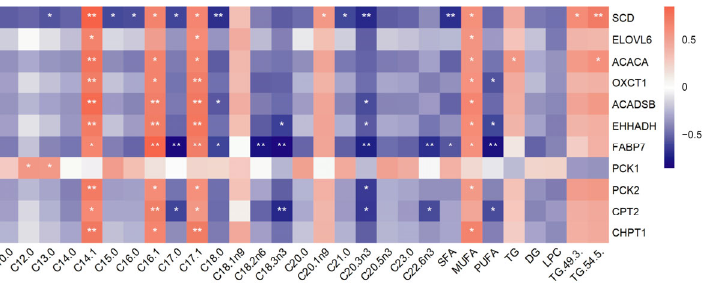
Figure 11. Correlation analysis between candidate genes related to fat deposition and differential fatty acids and lipids. The legend on the right shows the correlation coefficient. Red and blue represent the positive and negative correlation, respectively. The asterisk indicates significance: ** p < 0.01, * p < 0.05.